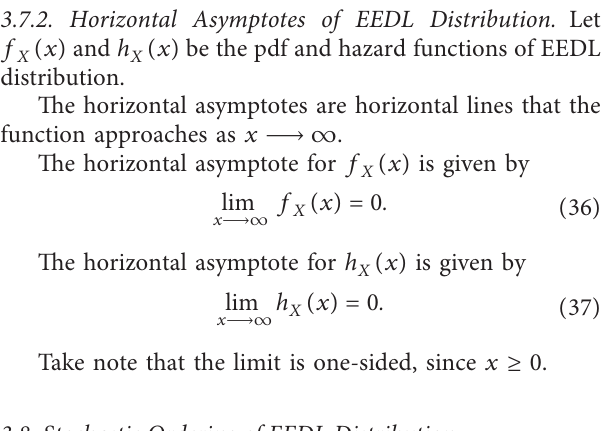
real values of x ≥ 0.